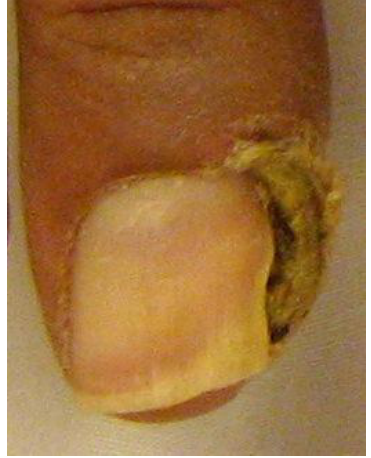
FIGURE 2 . Calciphylaxis involving middle